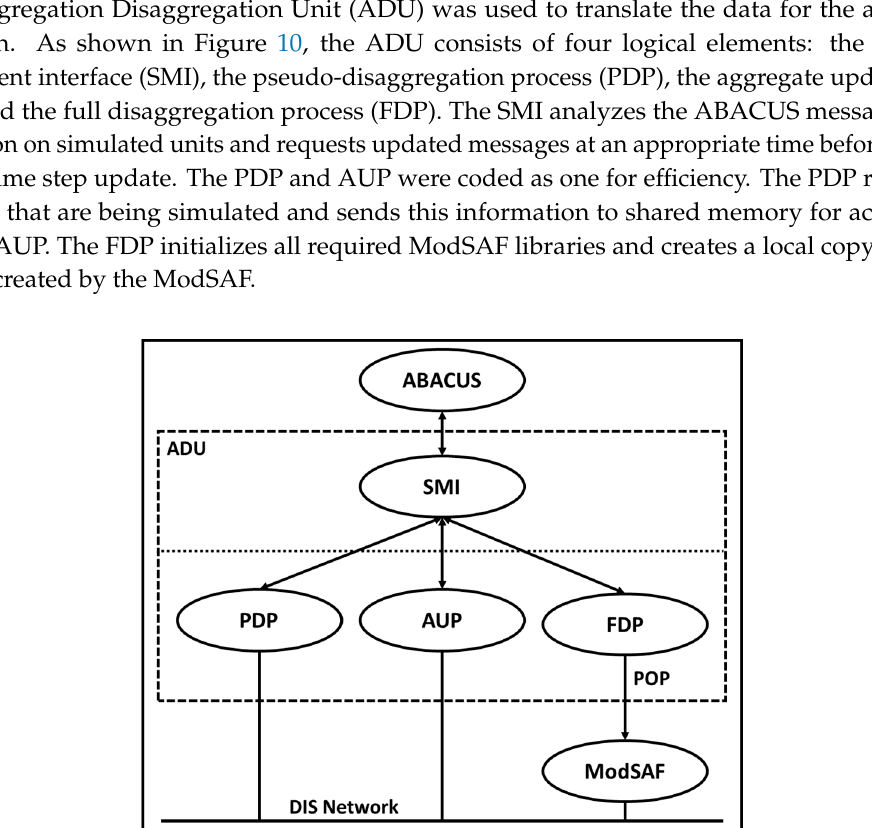
Figure 11. Eagle/ITEMS network configuration and implementation (adapted from [41]).